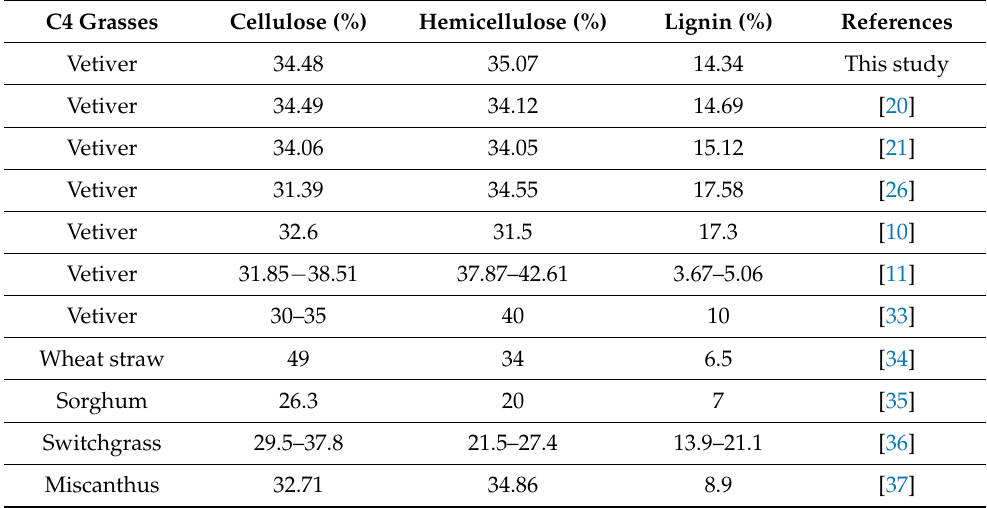
Table 1. Comparison of the main composition of VG and other C4 grasses from previous reports.